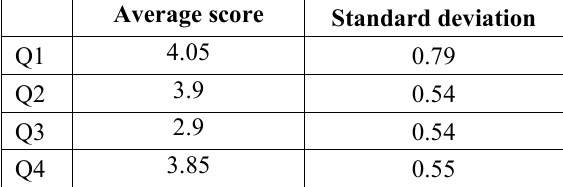
Figure 8 Spring force diagram Table 1. Experiment